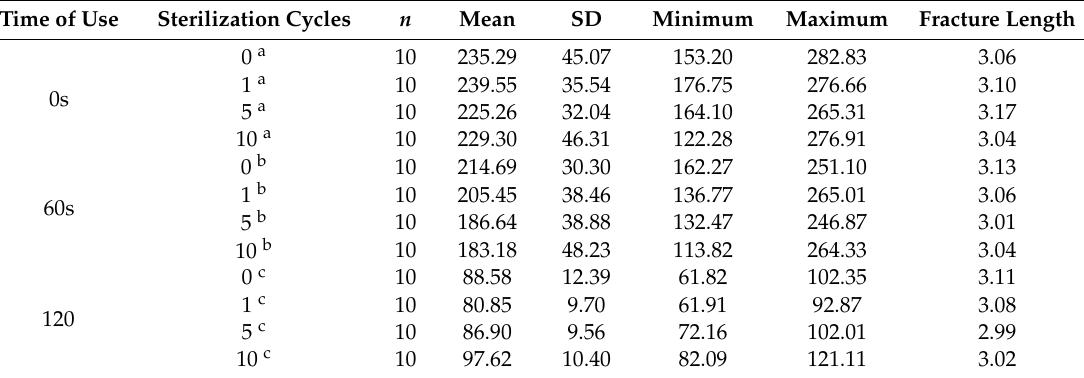
Table 5. Descriptive statistics of the number of cycles of in-and-out movement for the time of use and sterilization cycles study groups.